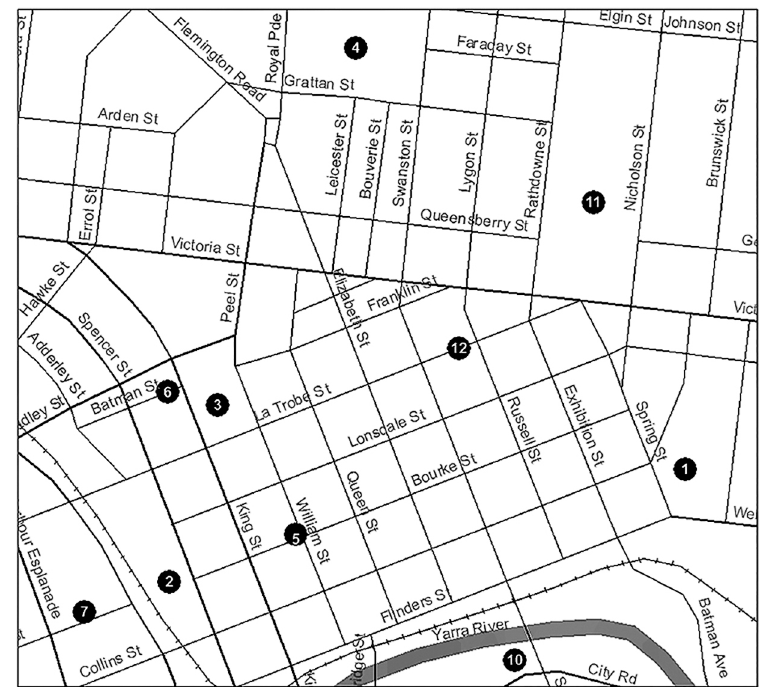
Figure. Map sites of the survey sessions in Melbourne